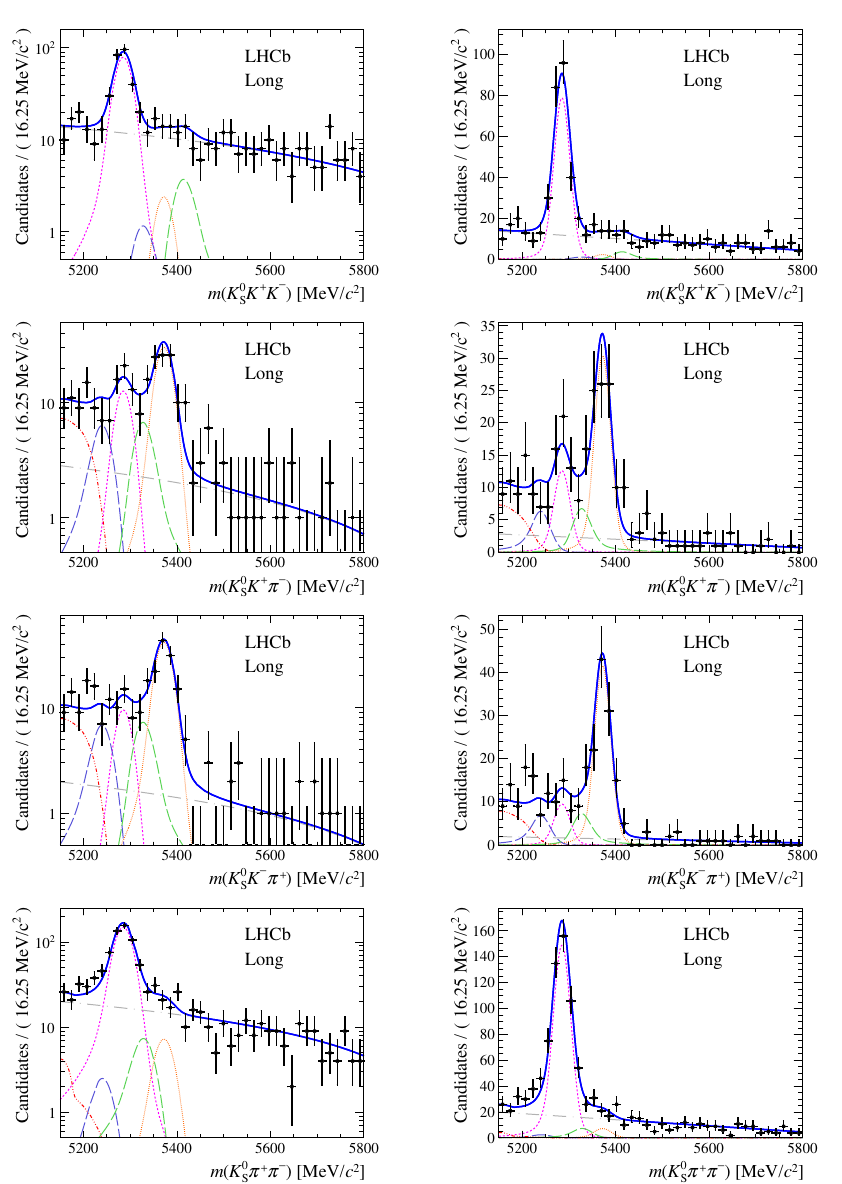
Figure 6 . Results of the simultaneous (cid:12)t to data (long, 2011) with the BDT optimisation corre- sponding to the favoured decay modes. The modes K 0 are shown from top to bottom. The left-hand side plots show the results with a logarithmic scale and the right-hand side with a linear scale. Legend is similar to that of plots shown in (cid:12)gure 1.